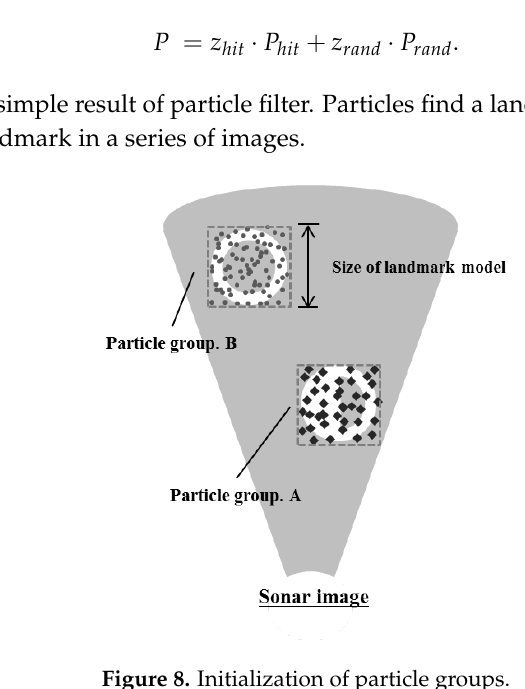
Figure 8. Initialization of particle groups.